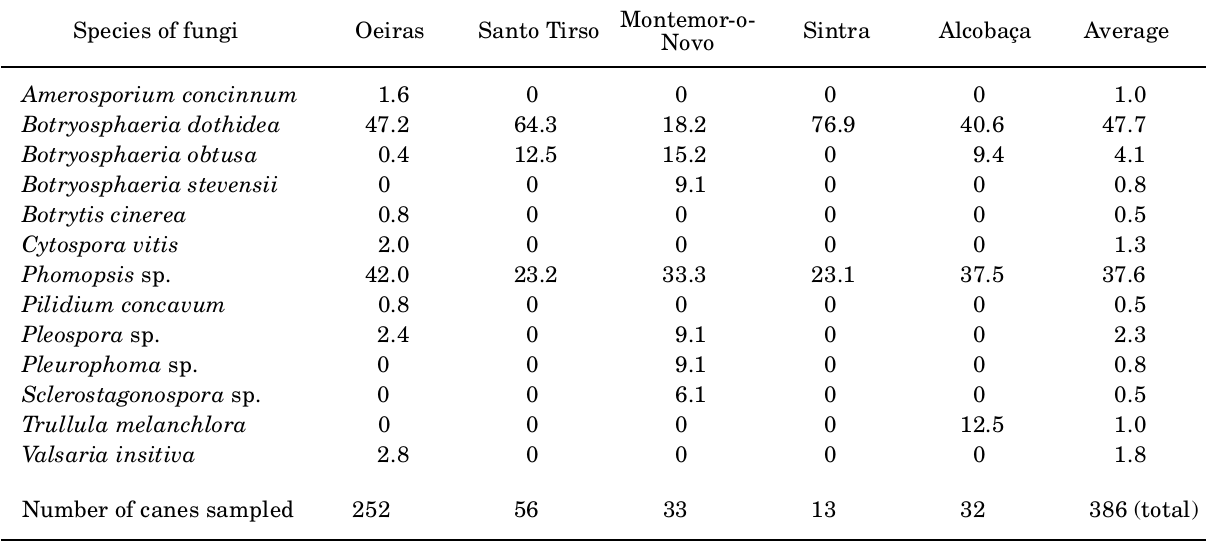
Table 1. Fungi associated with cane bleaching in five vineyards in Portugal (percentage of canes affected).